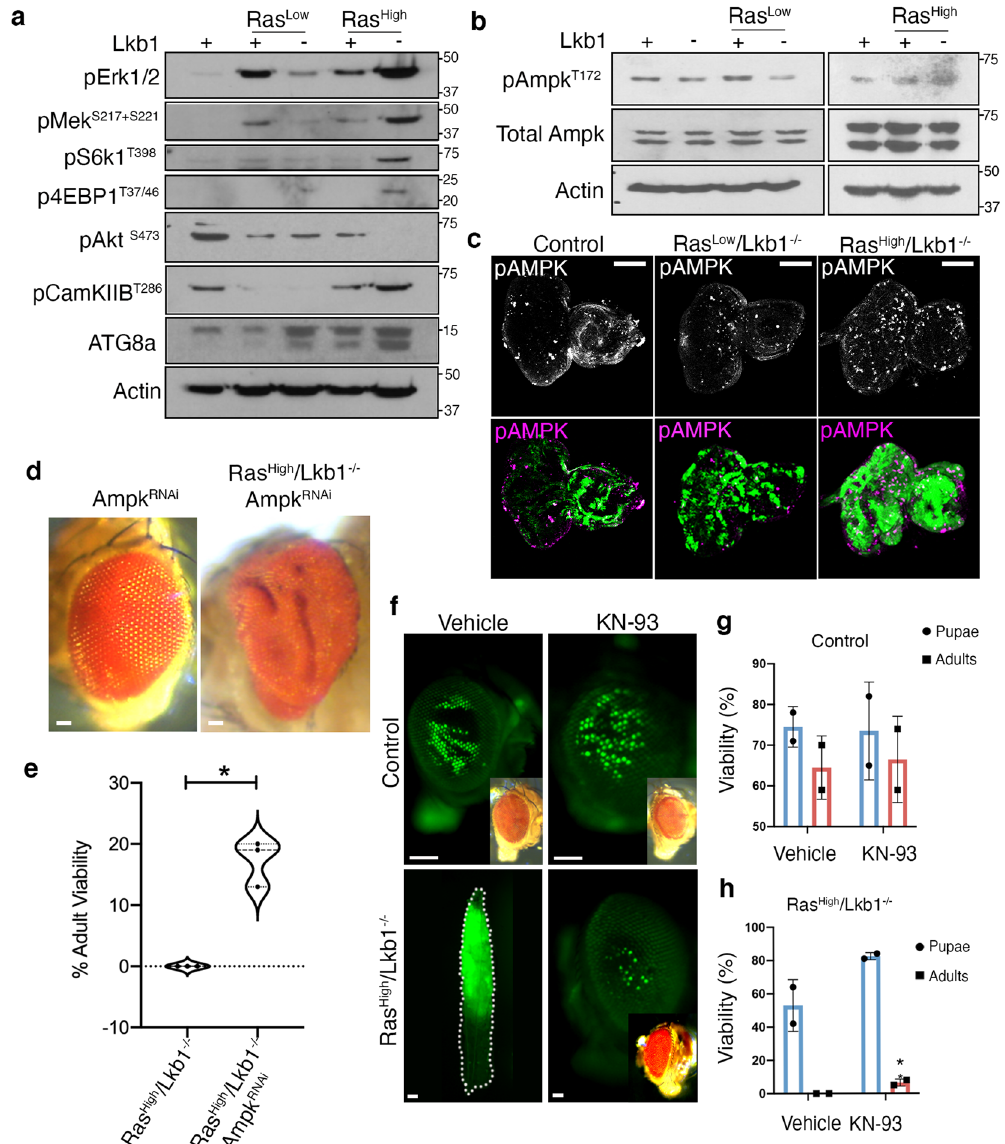
Fig. 5 Neoplastic Ras High / Lkb1 − / − tumors depend on the genetic dose of ampk and are targetable with a CaMK inhibitor. a Western analysis to assay activation of the indicated molecular pathways in mosaic larval eye-imaginal discs of the indicated genotypes. b Western analysis of Ampk activation from mosaic larval eye-imaginal discs of the indicated genotypes. c Confocal images of eye-imaginal discs carrying GFP + clones of the indicated genotypes (control = FRT82B ), and stained for phosphorylated Ampk. Images are representative of n = 10 independent eye-imaginal discs per genotype. Scale bar, 100 µ m. d Representative bright fi eld images of adult eyes carrying clones of the indicated genotypes. e Violin plot showing % adult viability from the Ras High / Lkb1 − / − ( n = 204) and Ras High / Lkb1 − / − / ampk RNAi ( n = 139) genotypes from three independent experiments, * p -value = 0.0155 using a Welch ’ s t -test. Dashed line represents the median, dotted lines represent the upper and lower quartiles. f Representative fl uorescent and bright fi eld (inset) images of either fl ies carrying control ( FRT82B ) or GFP + Ras High / Lkb1 − / − clones that were pharmacologically treated with vehicle or the pan CaMK inhibiter KN-93 (5 µ M) as 1st instar larvae. Scale bars, 100 µ m. g , h The percent survival to pupal and adult stages was quanti fi ed for control ( FRT82B ) and Ras High / Lkb1 − / − vehicle and KN-93 treated larvae. Data are represented as mean percent survival with error bars representing standard deviation. n = 50 biologically independent animals/genotype/condition/2 independent experiments. * p -value = 0.0493 computed from Unpaired t